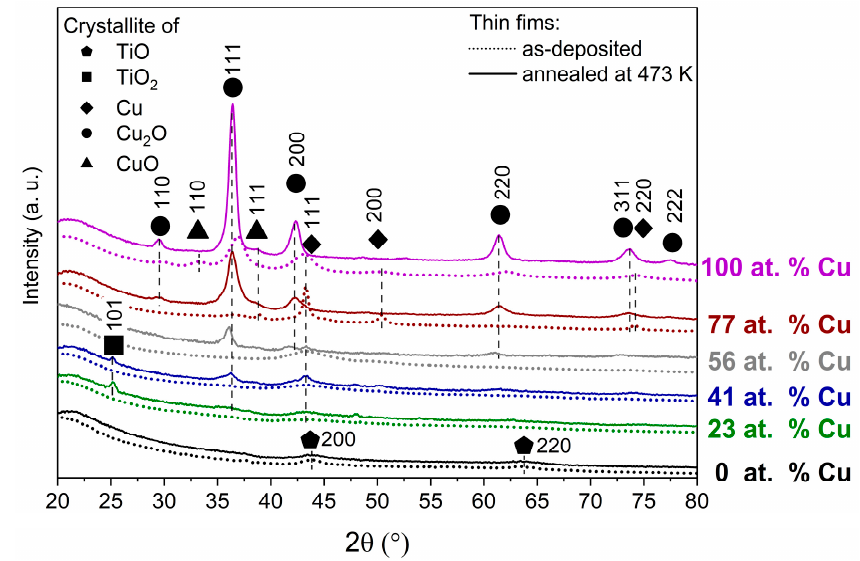
Figure 2. The di ff raction pa tt erns of the as-deposited and annealed at 473 K TiO x , (CuTi)Ox, and Figure 2. The diffraction patterns of the as-deposited and annealed at 473 K TiO x , (CuTi)Ox, and Cu x O thin fi lms. Cu x O thin